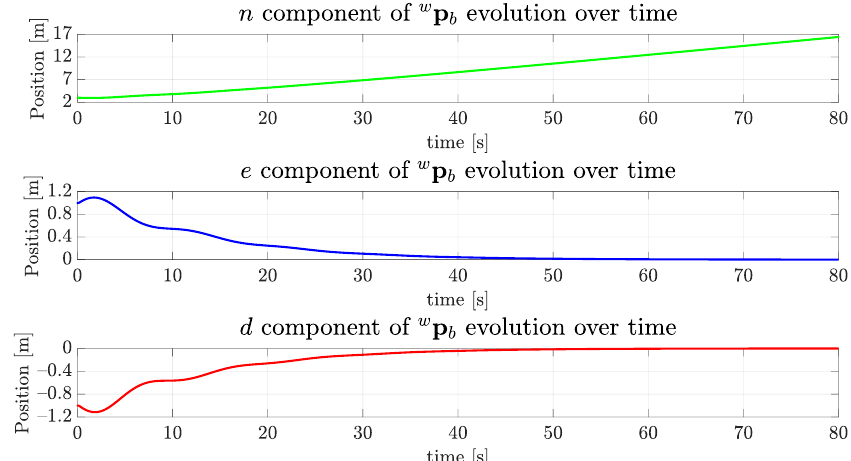
Figure 18. The evolution of the position components of the simulated vehicle over time for the straight path.